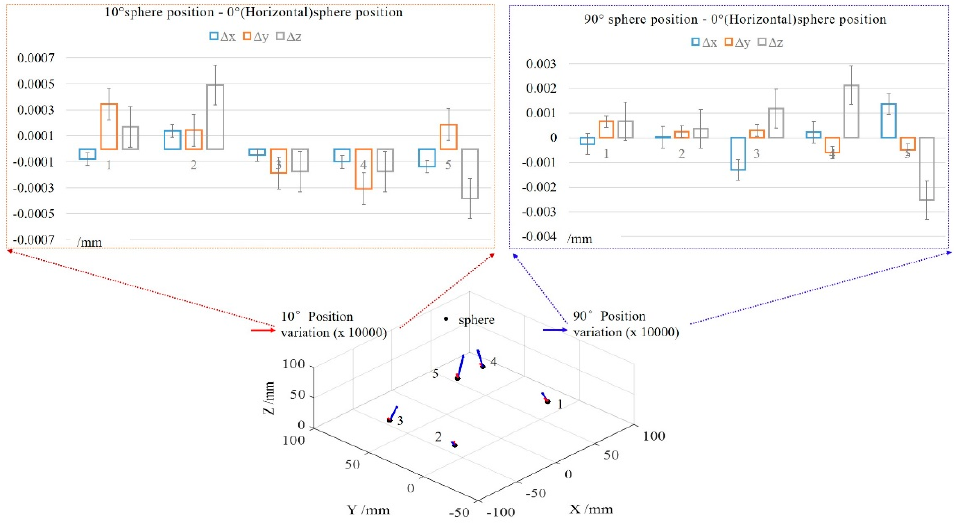
Figure 5. Position deviations of the fiducials when changing the artefact from a horizontal to a 10-degree ( O-H ) position and into a vertical orientation ( V-H ). The error vectors are multiplied by 10,000 in the bottom plot. The top two graphs are position deviations in three directions with their uncertainties.